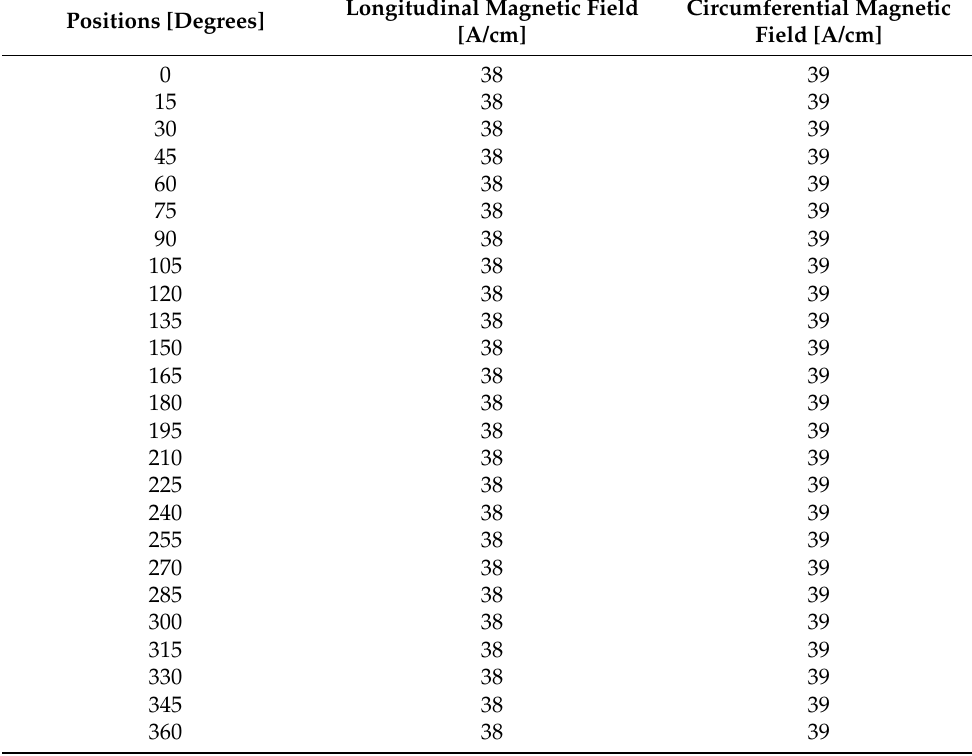
Table 2. Changes of tangential magnetic field parameters using an auxiliary